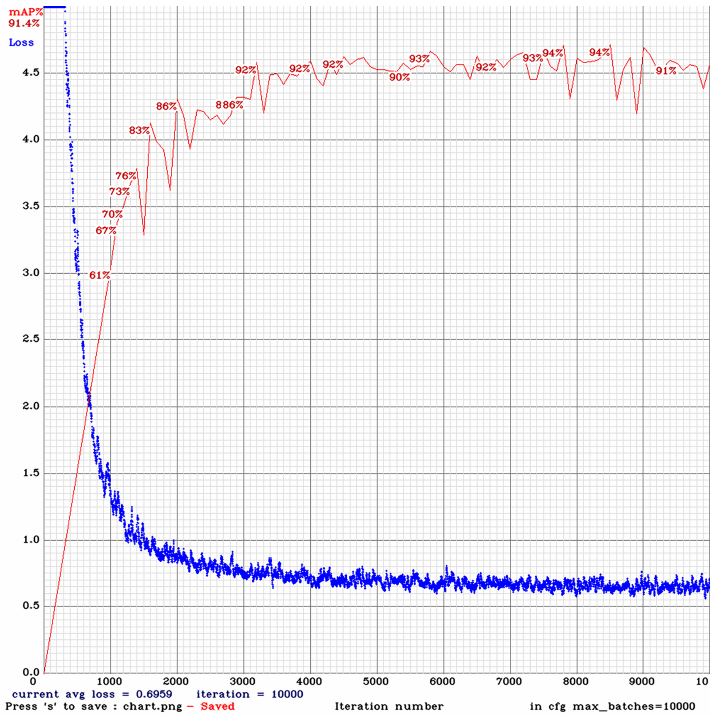
Figure 13. Training phase of the improved